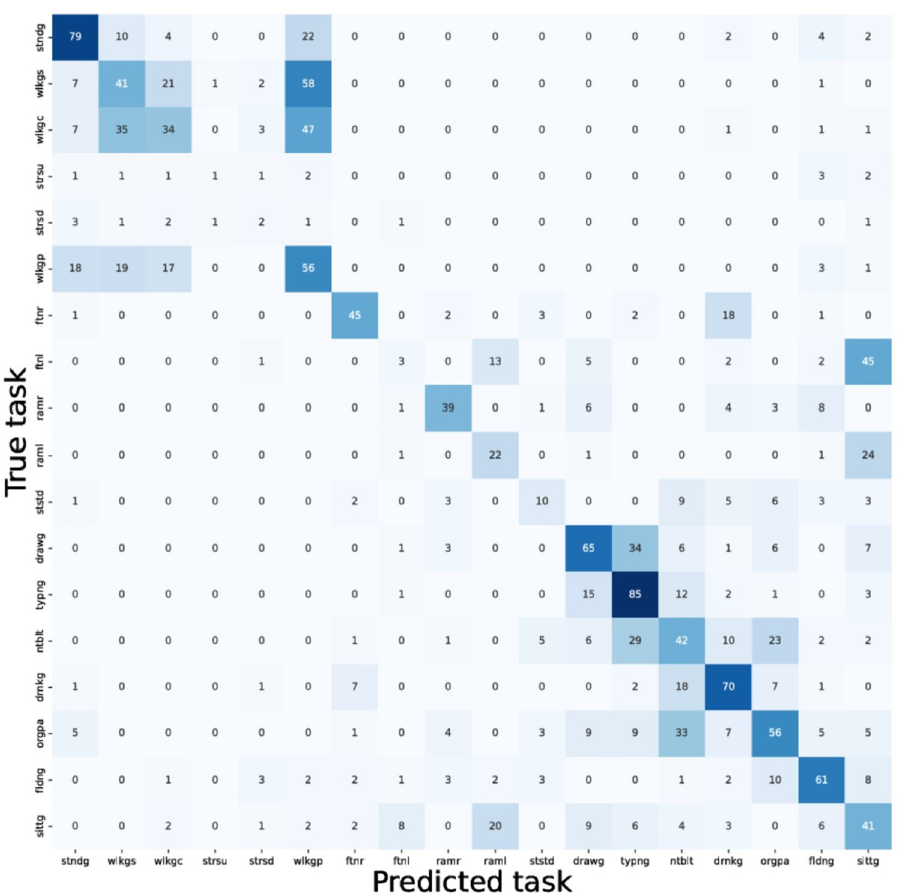
Fig 8. A confusion matrix for predictions of tasks using representations from a VAE trained on MJFFd. Data from Boston site was used for training, and data from NYC site for testing.